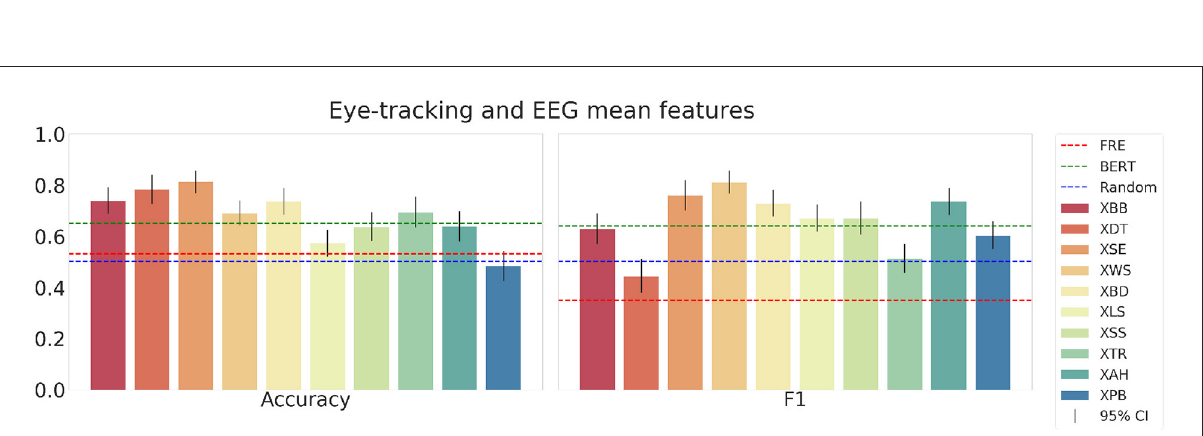
FIGURE10 The mean accuracy (left) , mean F1-score (right) with corresponding 95% confidence intervals and textual baselines are plotted for each subject in the held-out test dataset using the eye-tracking and EEG mean features.